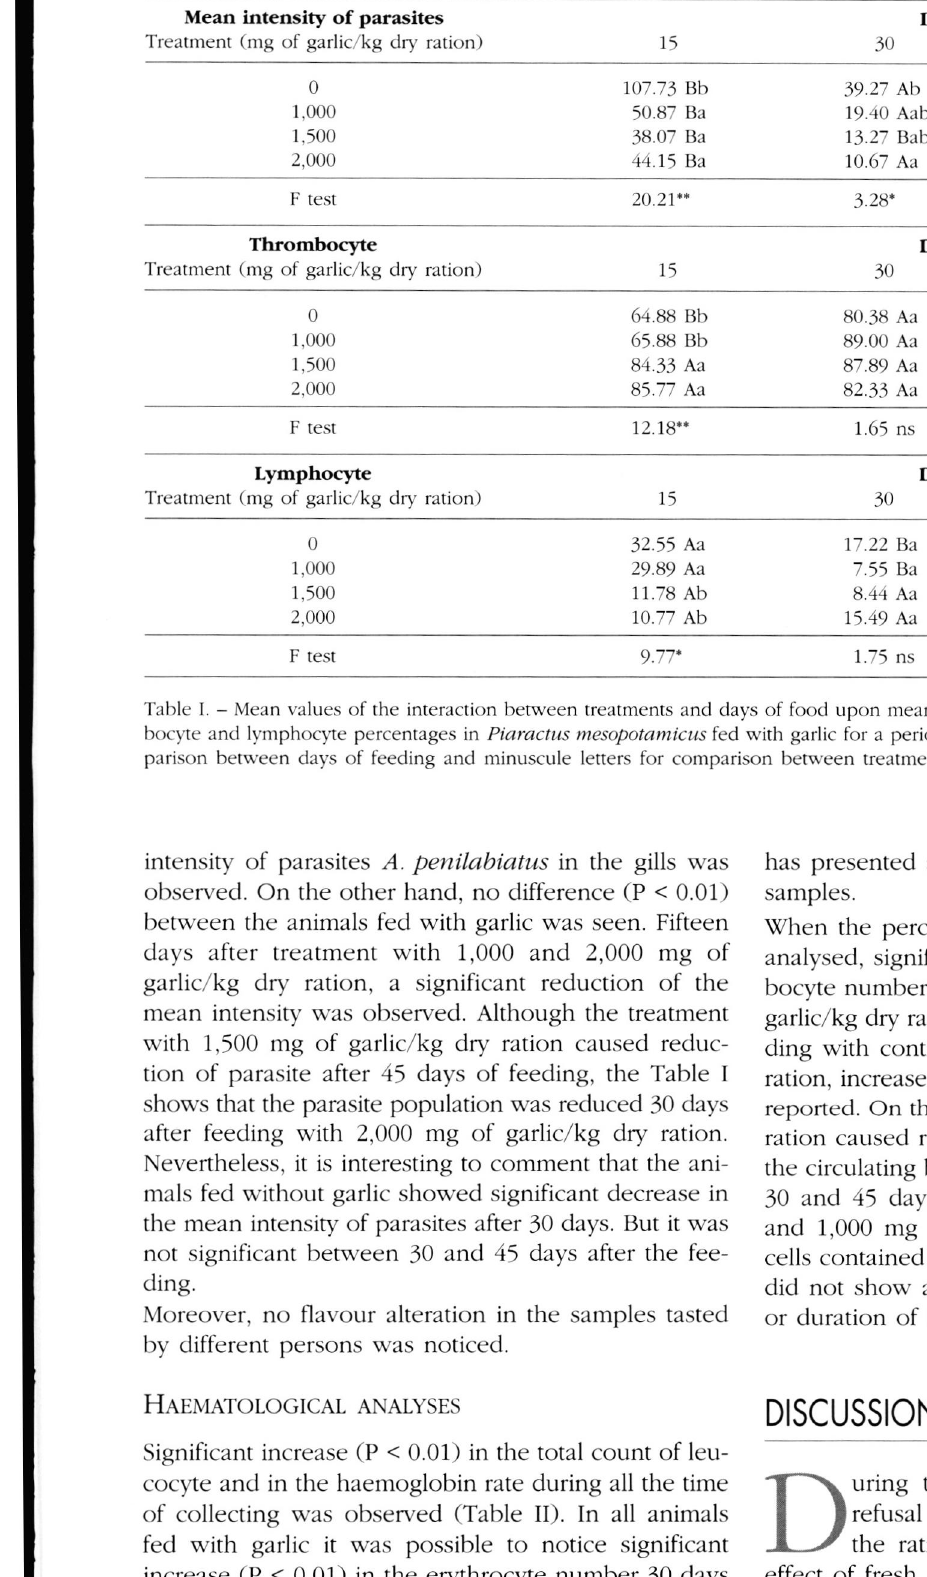
Days of feeding